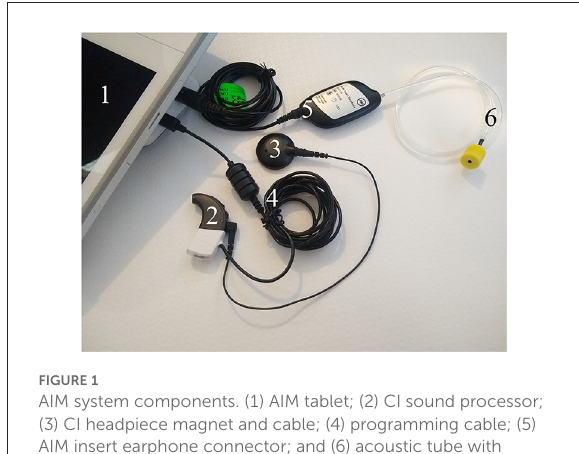
FIGURE1 AIM system components. (1) AIM tablet; (2) CI sound processor; (3) CI headpiece magnet and cable; (4) programming cable; (5) AIM insert earphone connector; and (6) acoustic tube with yellow foam ear